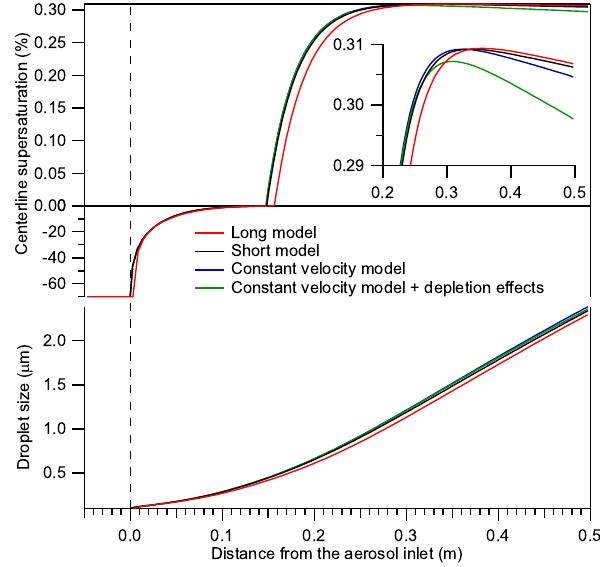
Fig. 2. Simulated centerline supersaturation profiles and droplet size for 90nm ammonium sulfate particles. Maximum supersaturation is set to 0.3% for 1000 mbar pressure and 0.5Lmin − 1 flow rate. Su- persaturation in sub- and supersaturated regions are shown in dif- ferent scales, and the inset shows an expanded view of the region with the highest